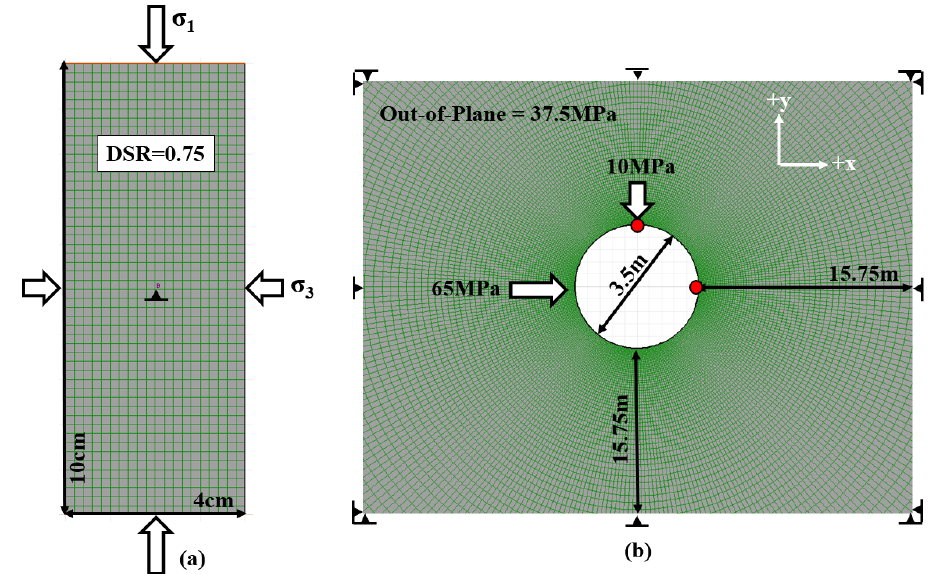
Figure 11. Model geometries from FLAC2D for ( a ) the lab-scale verification and ( b ) the tunnel-scale model modified from the AECL URL tunnel. Note that model dimensions and boundary conditions (pins) are shown. Red dots represent measurement points for displacement.